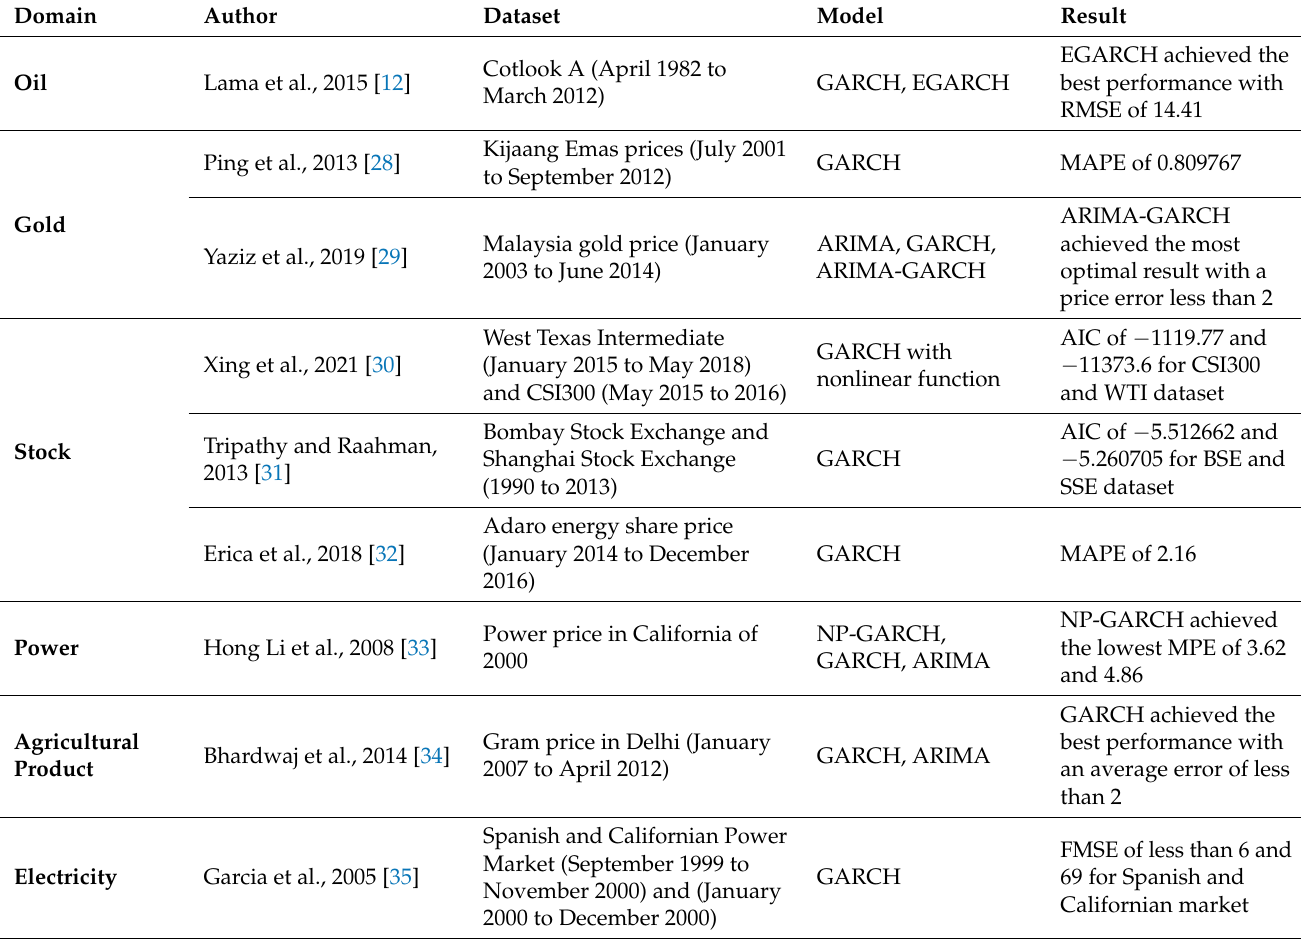
Table 3. GARCH time-series forecasting from 2005 to